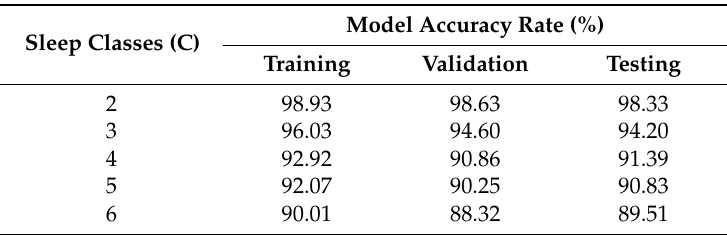
Table 6. Performance values for the sleep-edf data of the model for two to six sleep classes using a single electroencephalogram